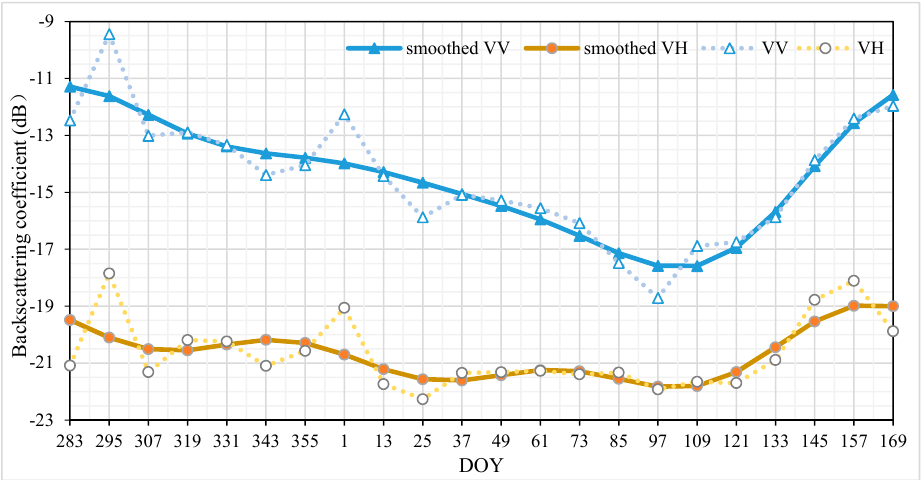
Figure 6. Smoothed Sentinel-1 backscatter time series of ROIs using the Harmonic Analysis of Time Series (HANTS) algorithm for winter wheat pixels in the test region of the North China